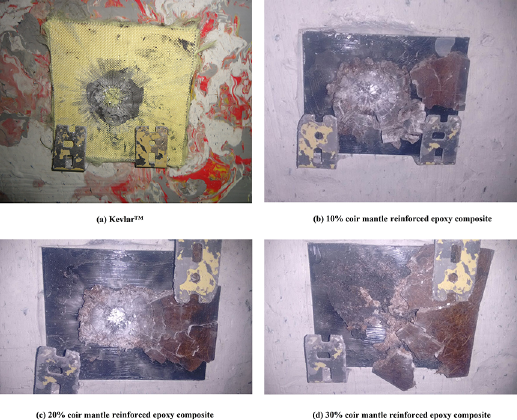
Figure 6. Aspect of MASs with different second layers after ballistic test against 7.62 mm bullet: (a) Kevlar™; (b) 10% coir mantle; (c) 20% coir mantle; and (d) 30% coir mantle reinforced epoxy composite.